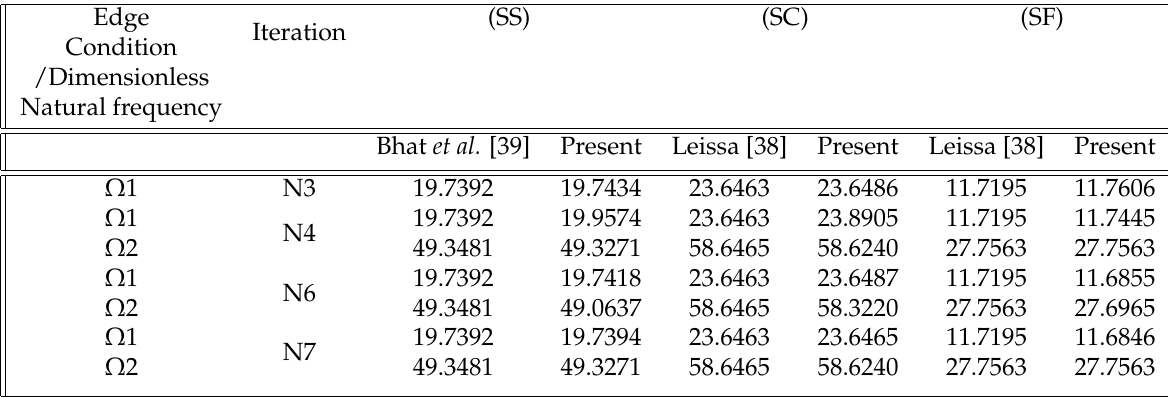
Table 4. Showing convergence study of the results